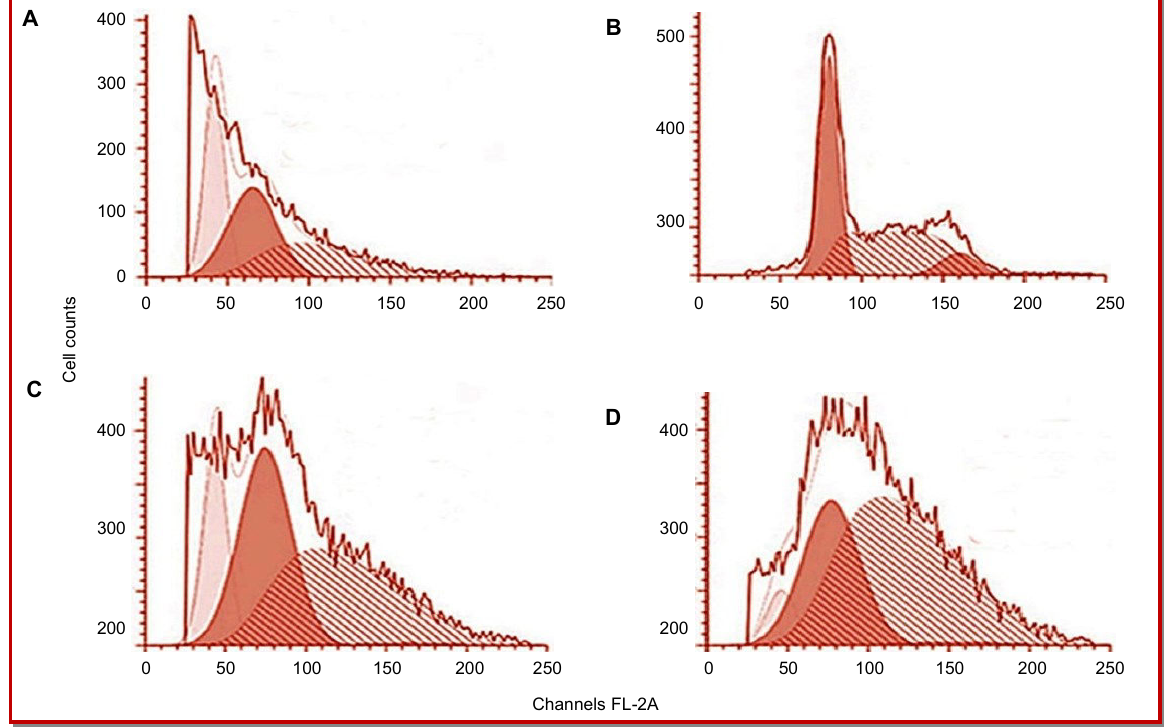
Figure 5: Bergaptol induces S-phase cell cycle arrest in in MCF-7 human breast cancer cells. Different doses of the compound were used, A represents untreated control, B represents 30 µM, C represents 90 µM and D represents 120 µM dose of bergaptol respectively. After treatment, cells were harvested and stained with propidium iodide, and then analyzed by flow cytometry